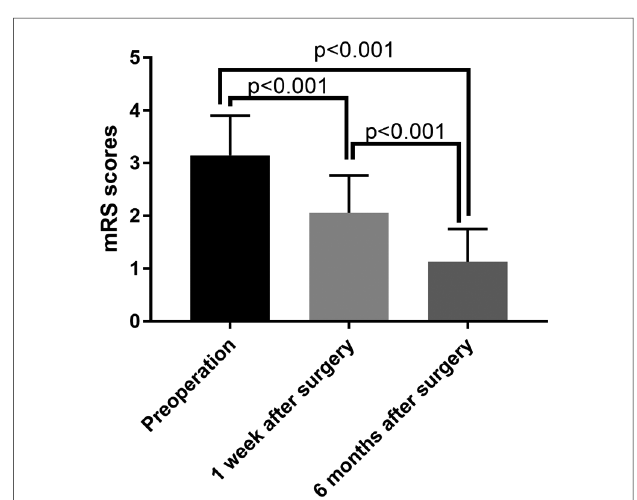
FIGURE 5 The comparison of mRS scores before and after surgery. mRS, modi fi ed Rankin